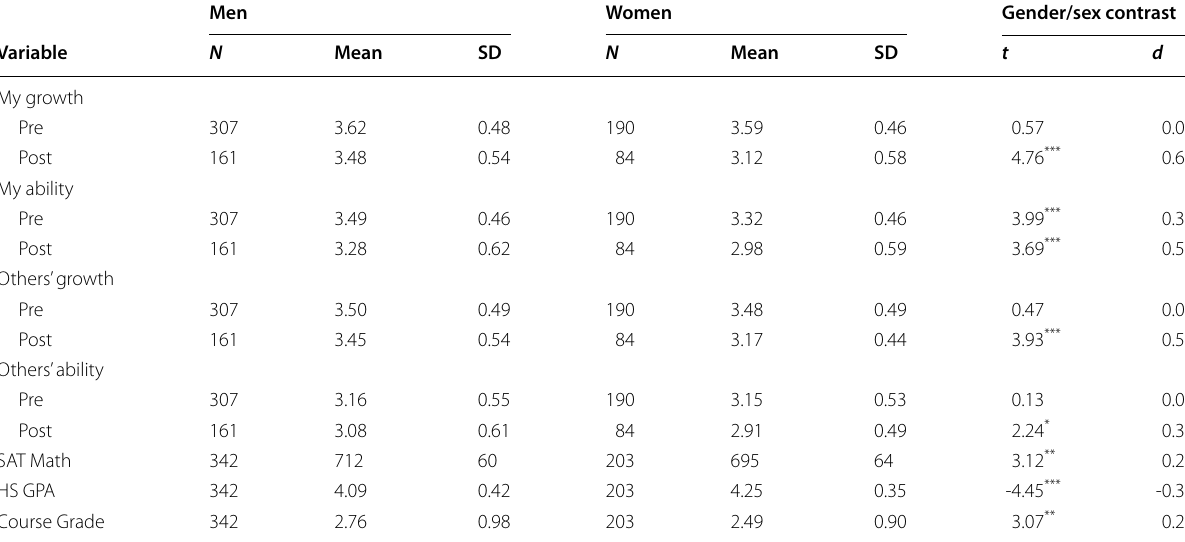
Mean and standard deviation (SD) by gender/sex of each mindset factor at pre and post, along with SAT Math, HS GPA, and Physics 1 grade, and Cohen’s d and t-test of gender/sex differences. Positive values of d and t indicate that men have a higher